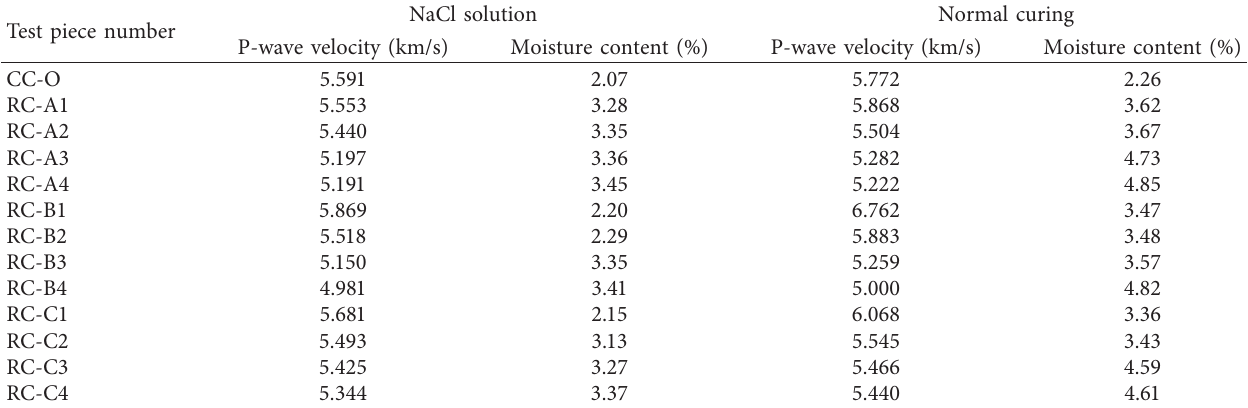
Table 2: P-wave velocity and water content of different solution soaking for 110